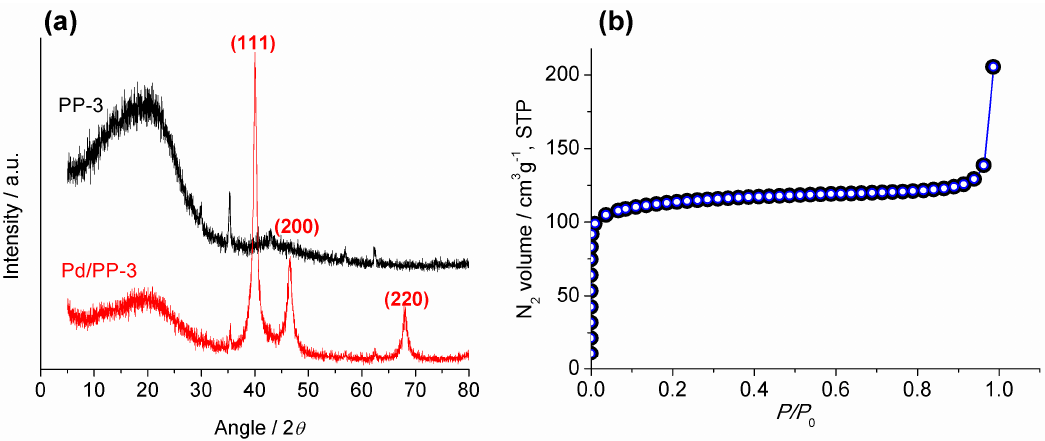
Figure 3. ( a ) Powder X-ray diffraction pattern; ( b ) N 2 adsorption-desorption isotherm of Pd/PP-3.